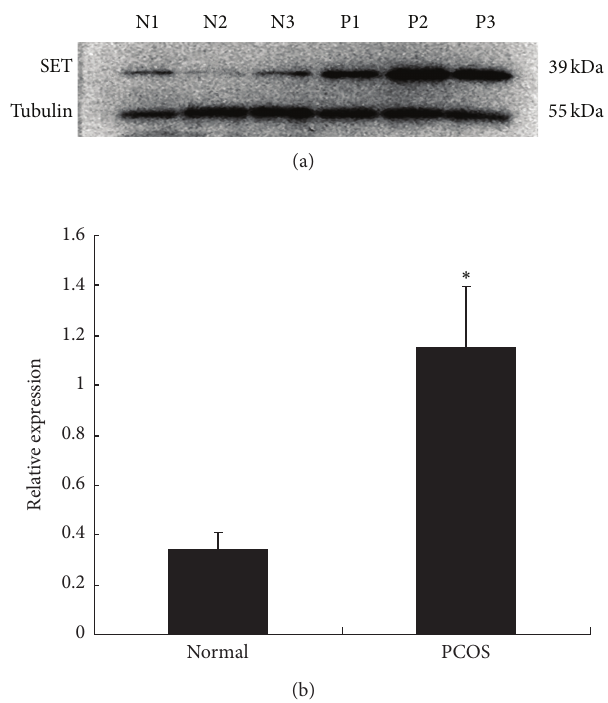
Figure 2: Expression of SET protein in polycystic and normal ovaries by Western blot assay. SET protein of polycystic ovaries was significantly increased when compared with normal ovaries ( 𝑃 < 0.05 ). Tubulin was used as internal